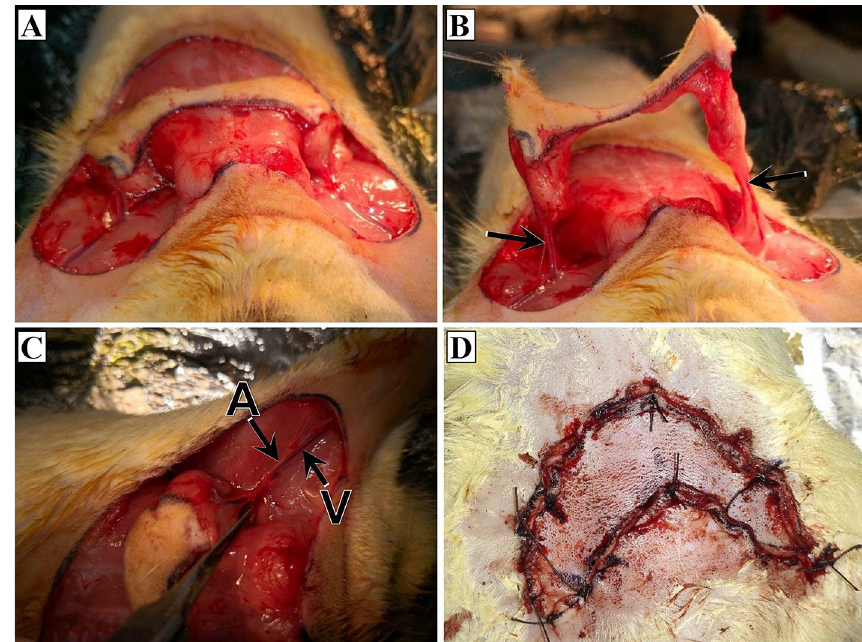
Figure 1. The surgical procedures. ( A ) The skin flap immediately after performing an incision. ( B ) Elevated skin with its panniculus carnosus preserving the supplying superficial inferior epigastric vessels at both sides (arrows). ( C ) The left superficial inferior epigastric artery (A) and vein (V) prior to ligation. ( D ) Repositioned skin flap after suturing with a nonabsorbable suture